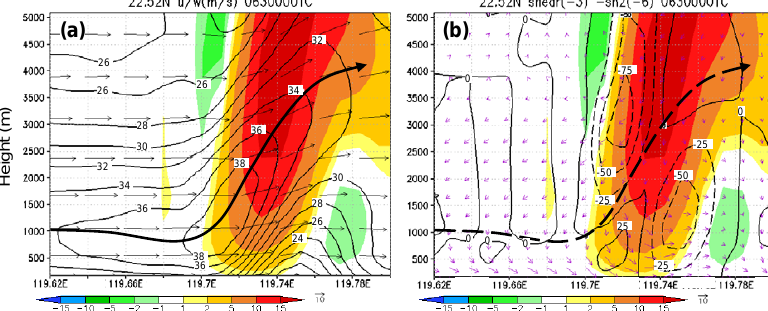
Figure 14. E–W vertical cross sections, through cell A1, of model-simulated w (ms − 1 , color, scale at bottom) and (a) wind vectors on the sec- tion plane (ms − 1 , reference vector at bottom), and u wind speed (ms − 1 , isotachs, every 2ms − 1 ) and (b) vertical wind shear (10 − 3 s − 1 , pur- ple vectors, reference vector at bottom) and − 1 times the x component of shearing term in Eq. (13) (10 − 6 Pam − 2 , every 25 × 10 − 6 Pam − 2 , dashed for negative values) along 22.52 ◦ N from 119.62 to 119.8 ◦ E (about 18km in length) at 06:30UTC, 8 August 2009. The thick (dashed) arrow lines in (a) and (b) mark the axis of